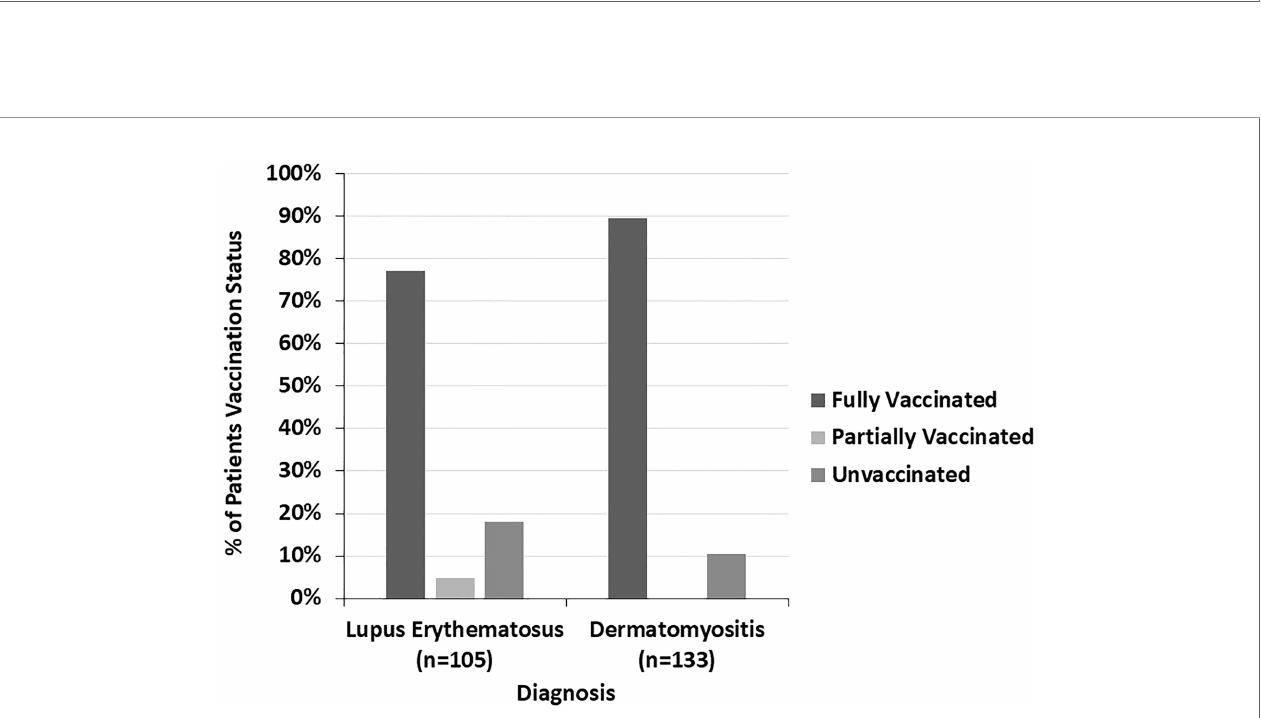
FIGURE 4 | The COVID-19 vaccination status of lupus erythematosus and dermatomyositis patients is shown here. A higher proportion of dermatomyositis patients were fully vaccinated compared to lupus erythematosus